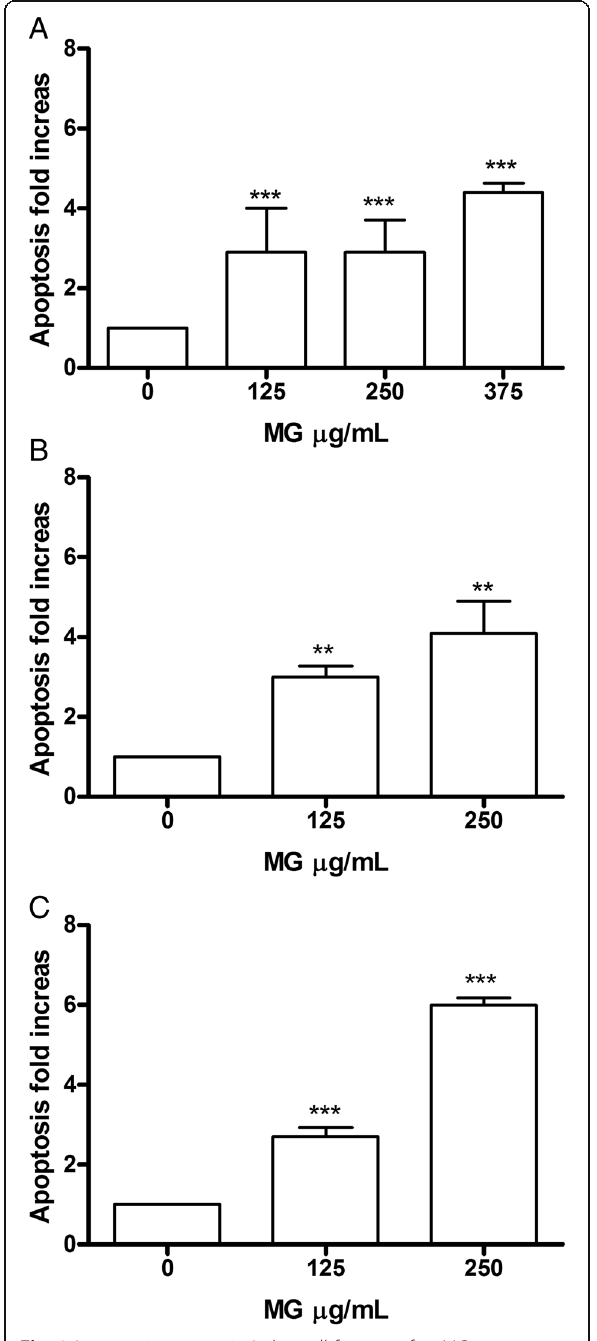
Fig. 3 Increase in apoptotic Jurkat cell fraction after MG treatment. Apoptosis was evaluated at 24 h ( a ), 48 h ( b ) and 72 h ( c ), as reported in Methods section. Each bar represents the mean ± SEM of five independent experiments. Data were analysed using repeated ANOVA followed by Bonferroni post-test. ** p < 0.01 vs control; *** p